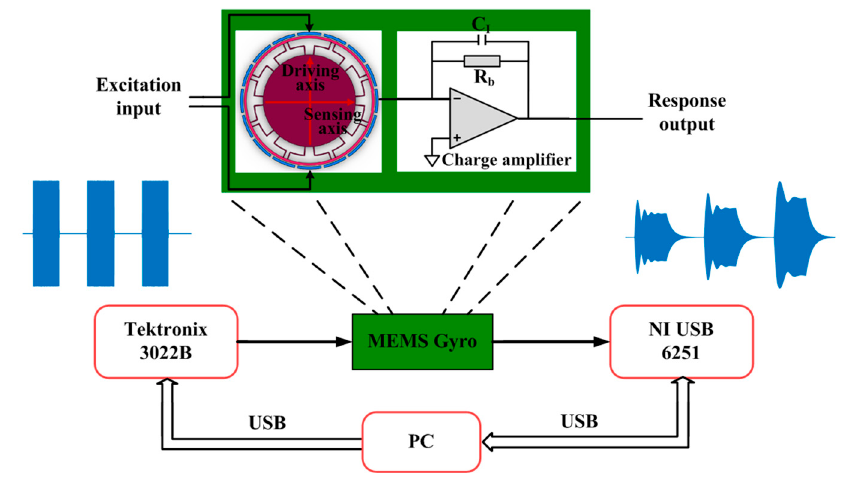
Figure 8. Experimental testing system.